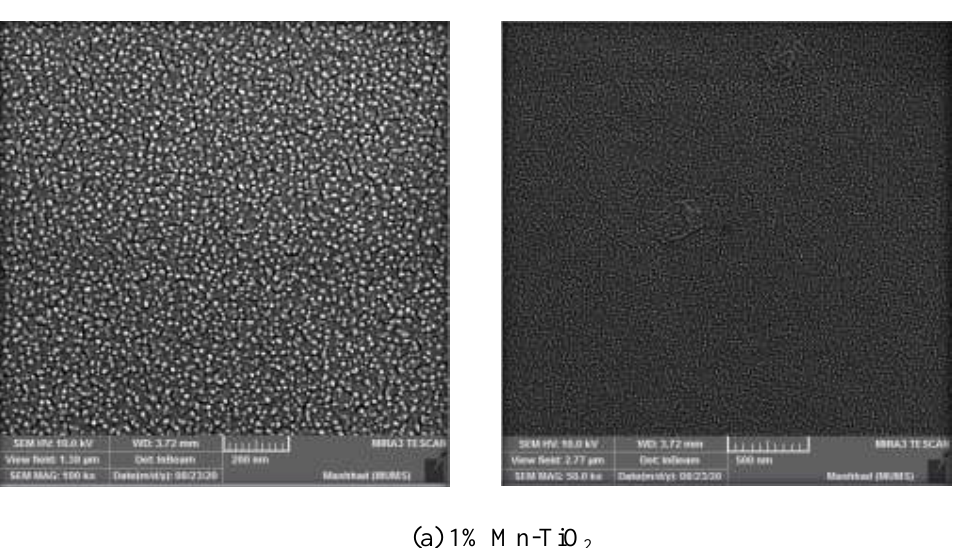
Fig.4: SEM images of Mn-doped TiO